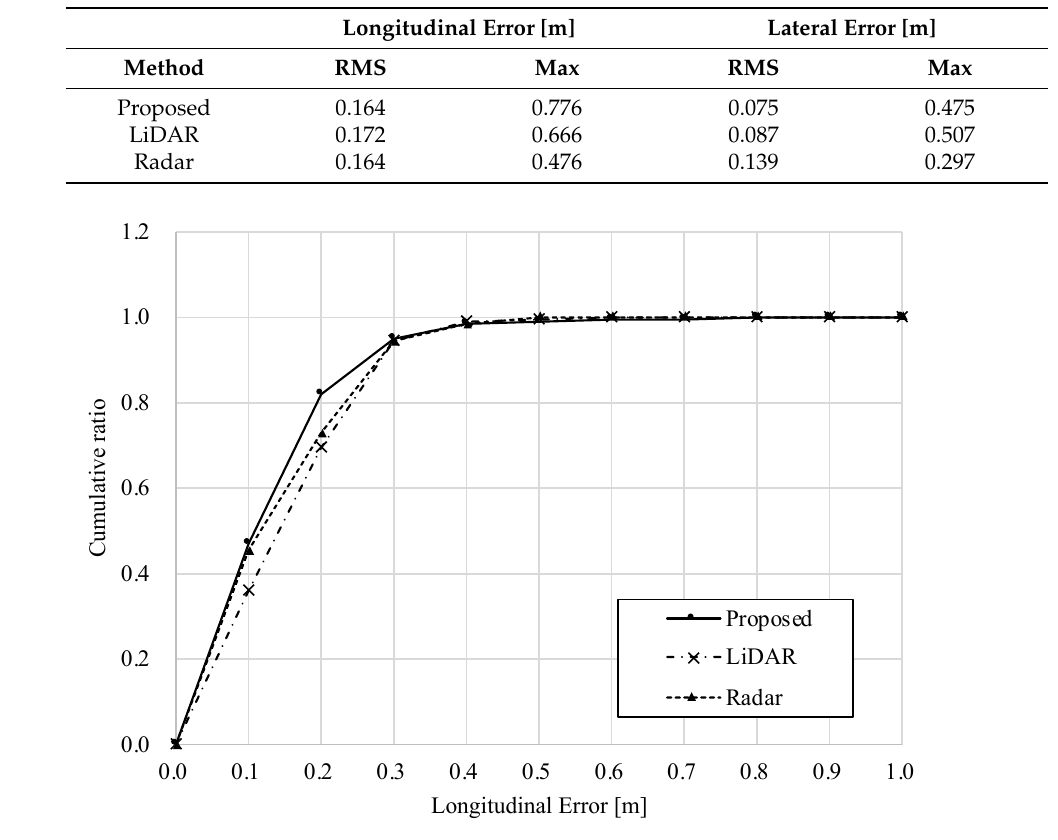
Figure 14. Longitudinal error in dry road surface condition.